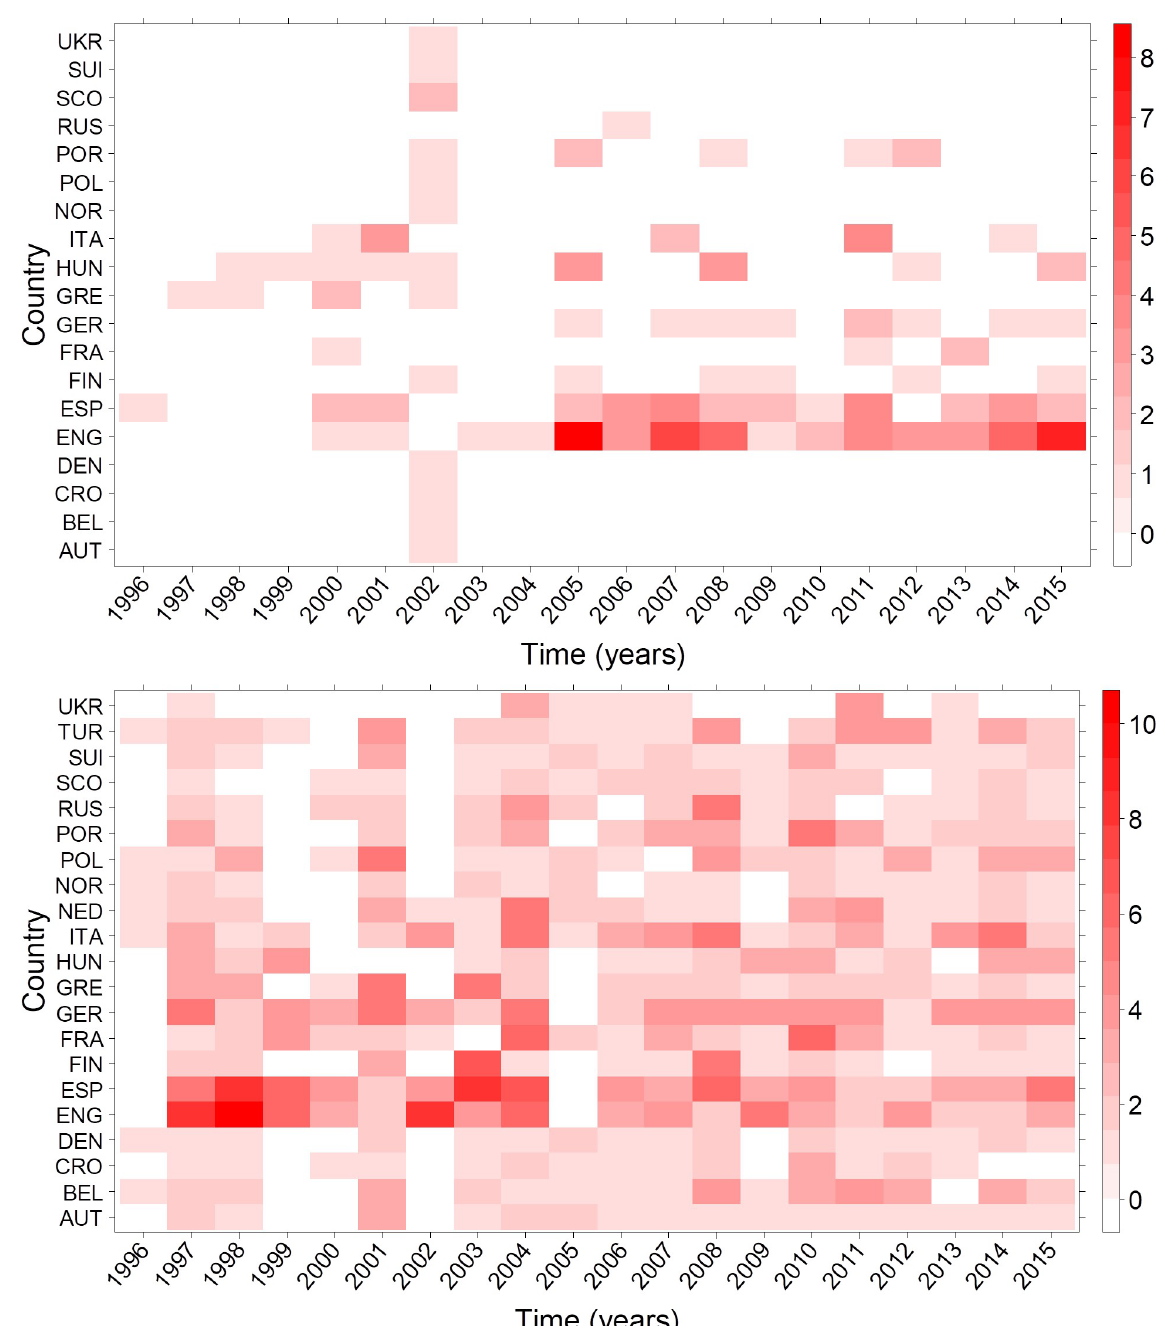
Fig 7. Evolution in the number of clubs in the blue and green cluster. Red squares represent the number of clubs of each league belonging to the blue (upper panel) or green (lower panel) cluster. Years in the x-labels correspond to the first year of the season (i.e. 1996 for 1996–1997